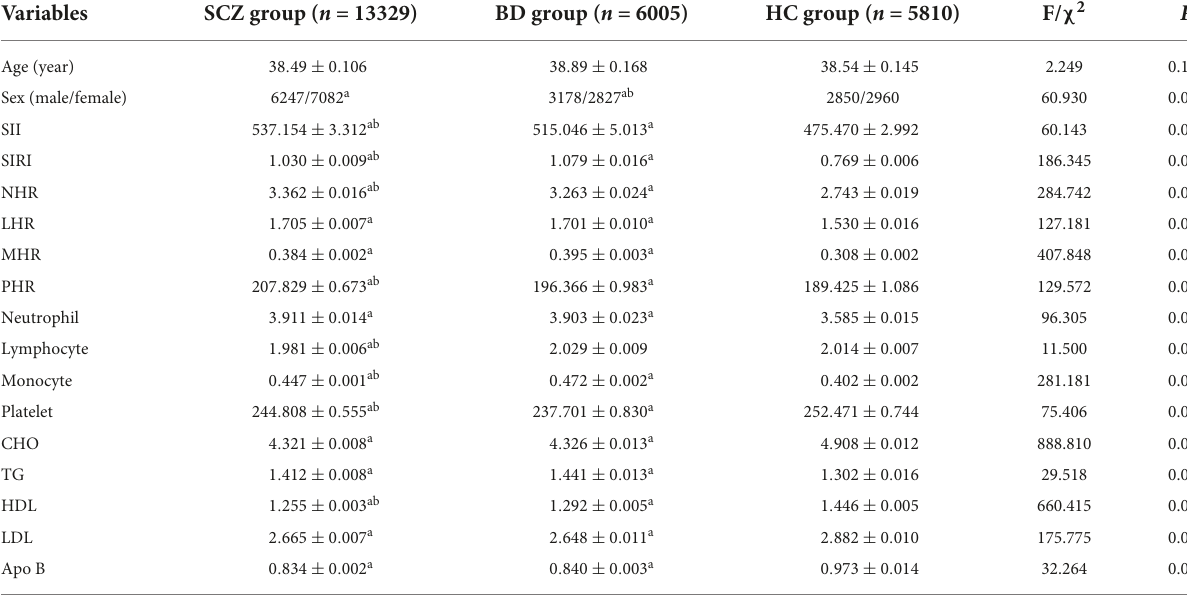
SCZ, schizophrenia; BD, bipolar disorder; HC, healthy control; CHO, cholesterol; TG, triglycerides; HDL, high-density lipoprotein; LDL, low-density lipoprotein; Apo B, apoprotein B; SII, systemic immune-inflammation index; SIRI, system inflammation response index; NHR, neutrophil/HDL ratio; LHR, lymphocyte/HDL ratio; MHR, monocyte/HDL ratio; PHR, platelet/HDLratio.a,vs.HCgroup, P < 0.05;b,vs.BDgroup, P < 0.05.Valuesarerepresentedasmean ±